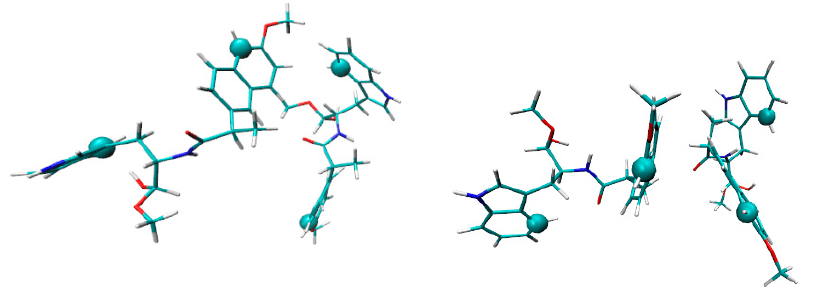
Figure 6. The approach of two molecules of ( S , S )-diastereomer of dyad I, forming a different types of dimers: approach of a NPX fragment with Trp (left) and two NPX residues (right). The distance between atoms marked by spheres was analyzed [20]. Table 7. Probability of dimer formation for various optical configurations of dyads I and II [20]. The fraction of time spent in dimer form, % ( R,S )-I